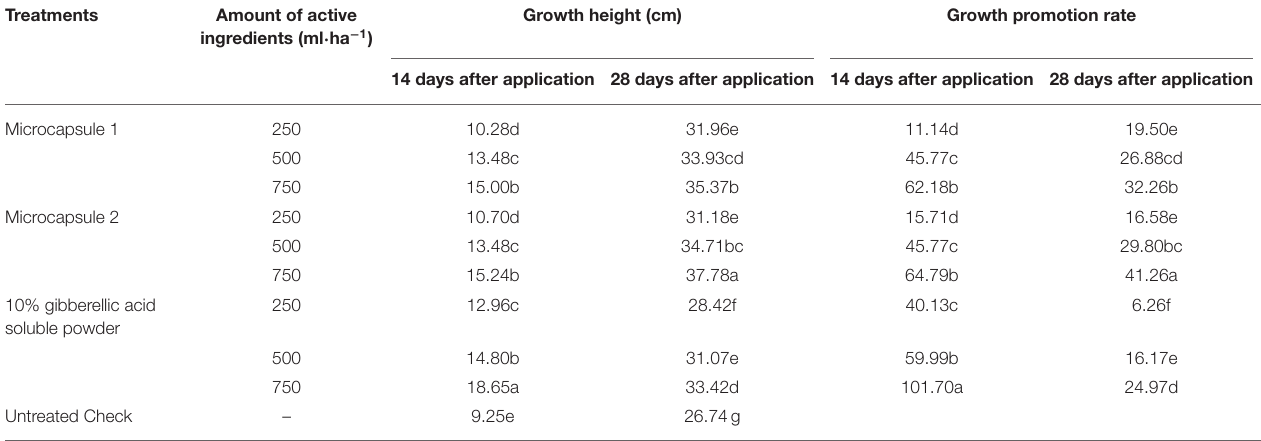
TABLE 2 | Detoxification effects of different pesticides on wheat.